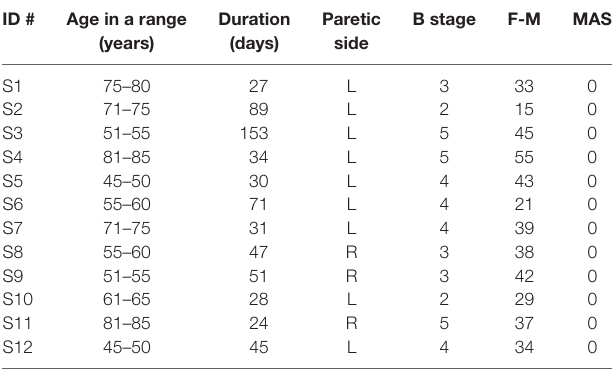
Table 1 | Demographic information for each stroke subject.